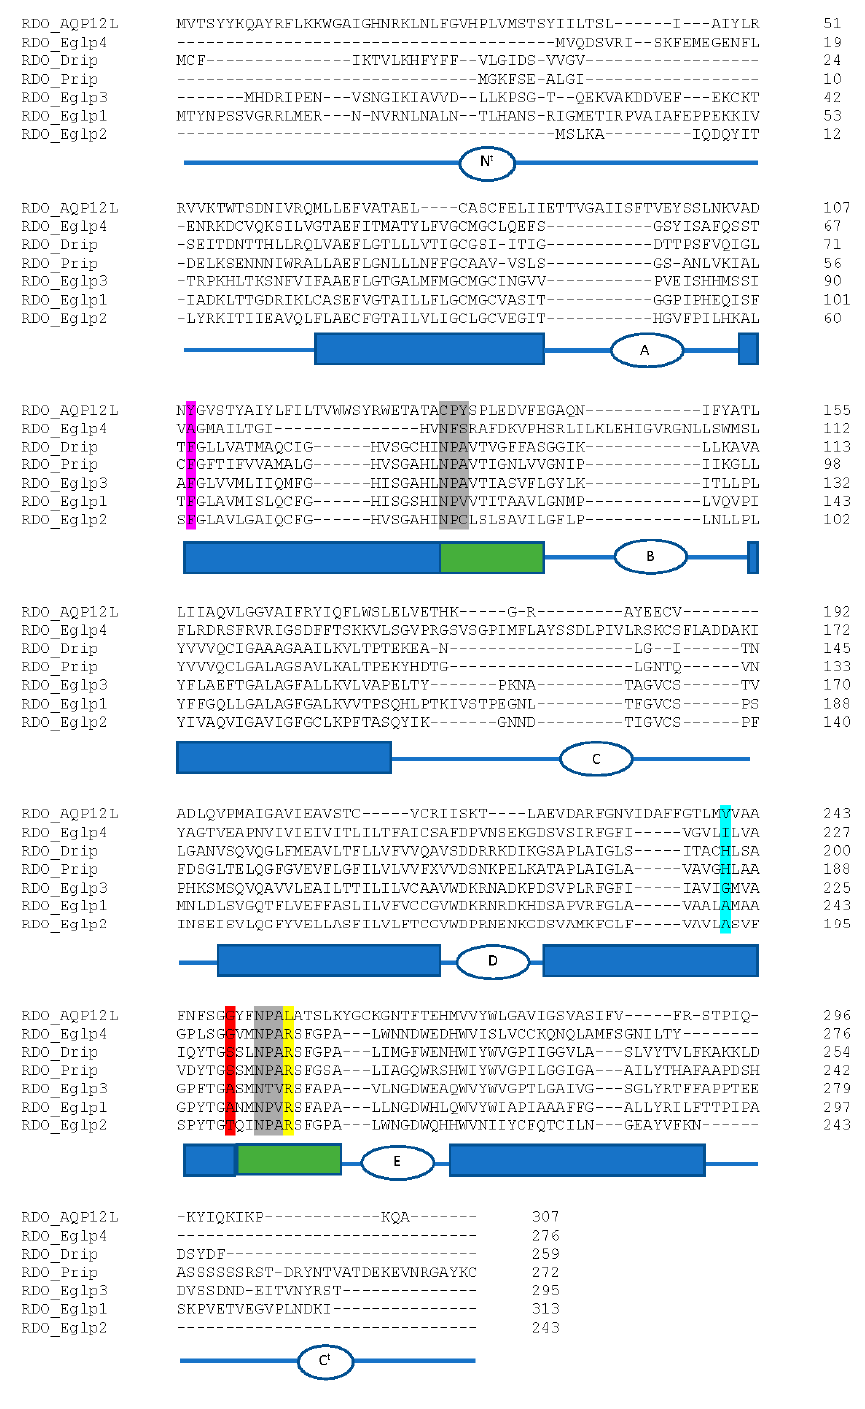
Figure 8. Amino acid sequence alignment of R. dominica aquaporins. The deduced amino acids of the R. dominica AQPs (excluding big brain) were aligned using CLUSTALW. NPA motifs are highlighted in grey. Residues that correspond to the ar/R selectivity site from Homo sapiens AQP1 (F56, H180, C189, R195; EAL24446.1) are highlighted in magenta, cyan, red, and yellow, respectively. Schematic below sequence alignment show domain structure based on predictions from the TMHMM Server v. 2.0. Rectangular boxes denote the position of the transmembrane helices (blue boxes) and the hemi-helices with the NPA motifs (green boxes). Intra- and extracellular loops A-E are denoted as ovals with letters. N t , amino-terminal domain, C t , carboxyl-terminal